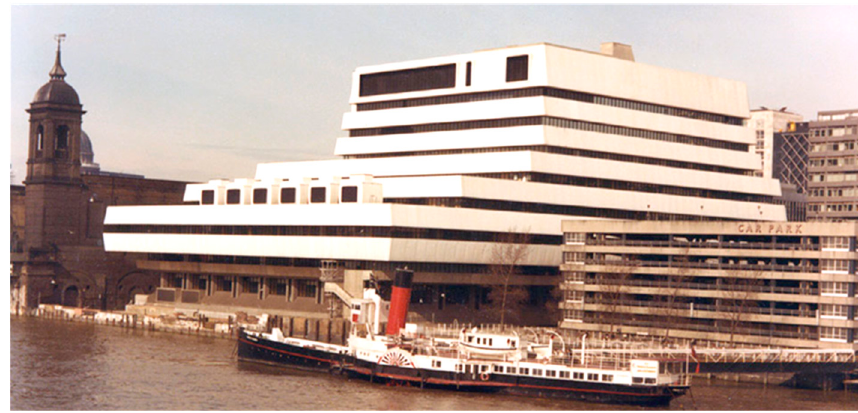
Figure 1. Mondial House, in London, built in 1974 and demolished in 2006.